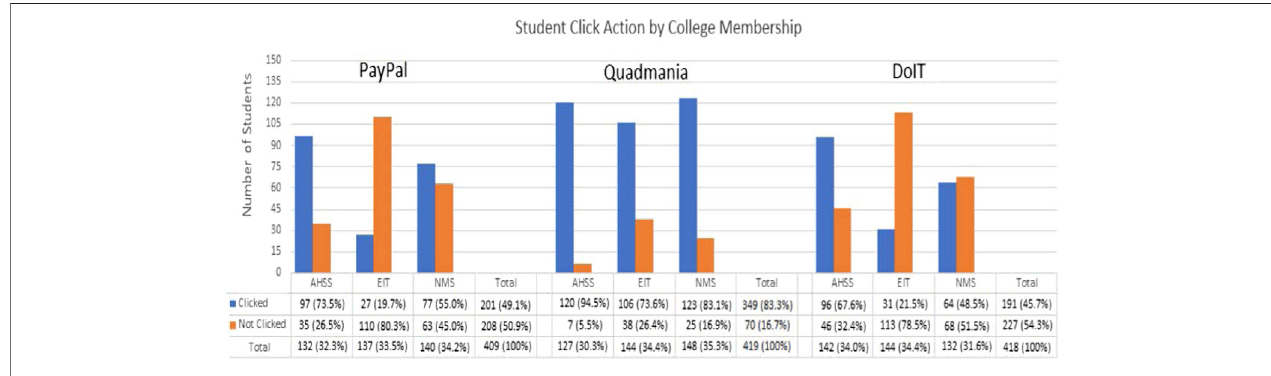
FIGURE 7 | The number of clicks on phishing emails by students in the College of Arts, Humanities, and Social Sciences (AHSS), the College of Engineering and Information Technology (EIT), and the College of Natural and Mathematical Sciences (NMS) at the University of Maryland, Baltimore County (UMBC) (Diaz et al., 2020).